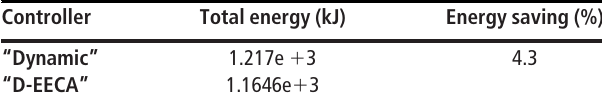
Table III Total energy